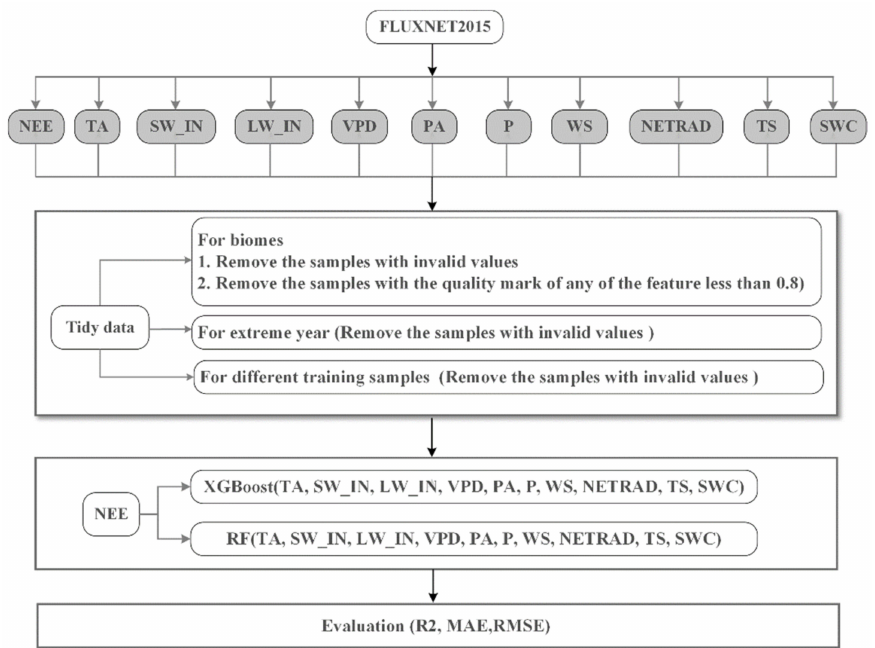
Figure 1. Flowchart of datasets and model setup. NEE is assumed to be the nonlinear function of TA, SW_IN, LW_IN, VPD, PA, P, WS, NETRAD, TS, and SWC. (NEE: Net ecosystem exchange; TA: Air temperature; SW_IN: Shortwave radiation, incoming; LW_IN: Longwave radiation, incoming; VPD: Vapor pressure deficit; PA: Atmospheric pressure; P: Precipitation; WS: Wind speed; NETRAD: Net radiation; TS: Soil temperature at the shallowest; SWC: Soil water content at the